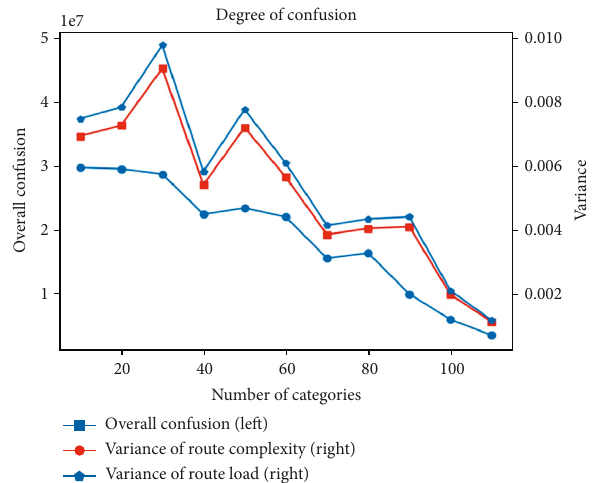
Figure 10: Index confusion under different